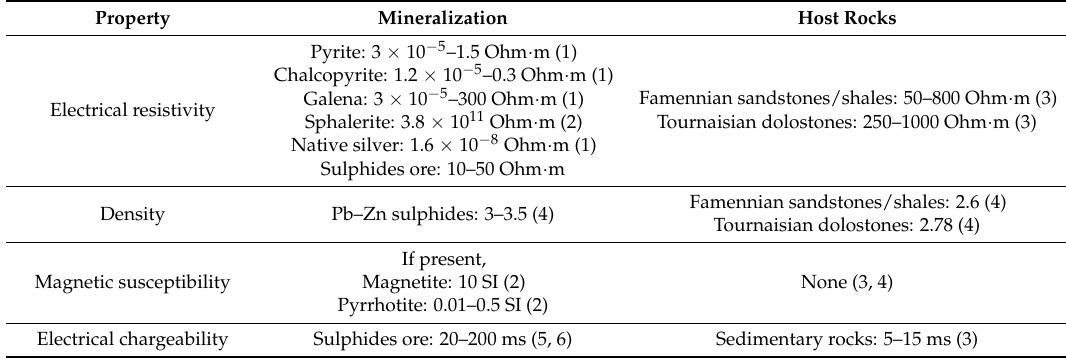
Table 2. Petrophysical properties of minerals and rocks. (1) [48]; (2) [18]; (3) field observation; (4) [48]; (5) [11,14]; and (6)